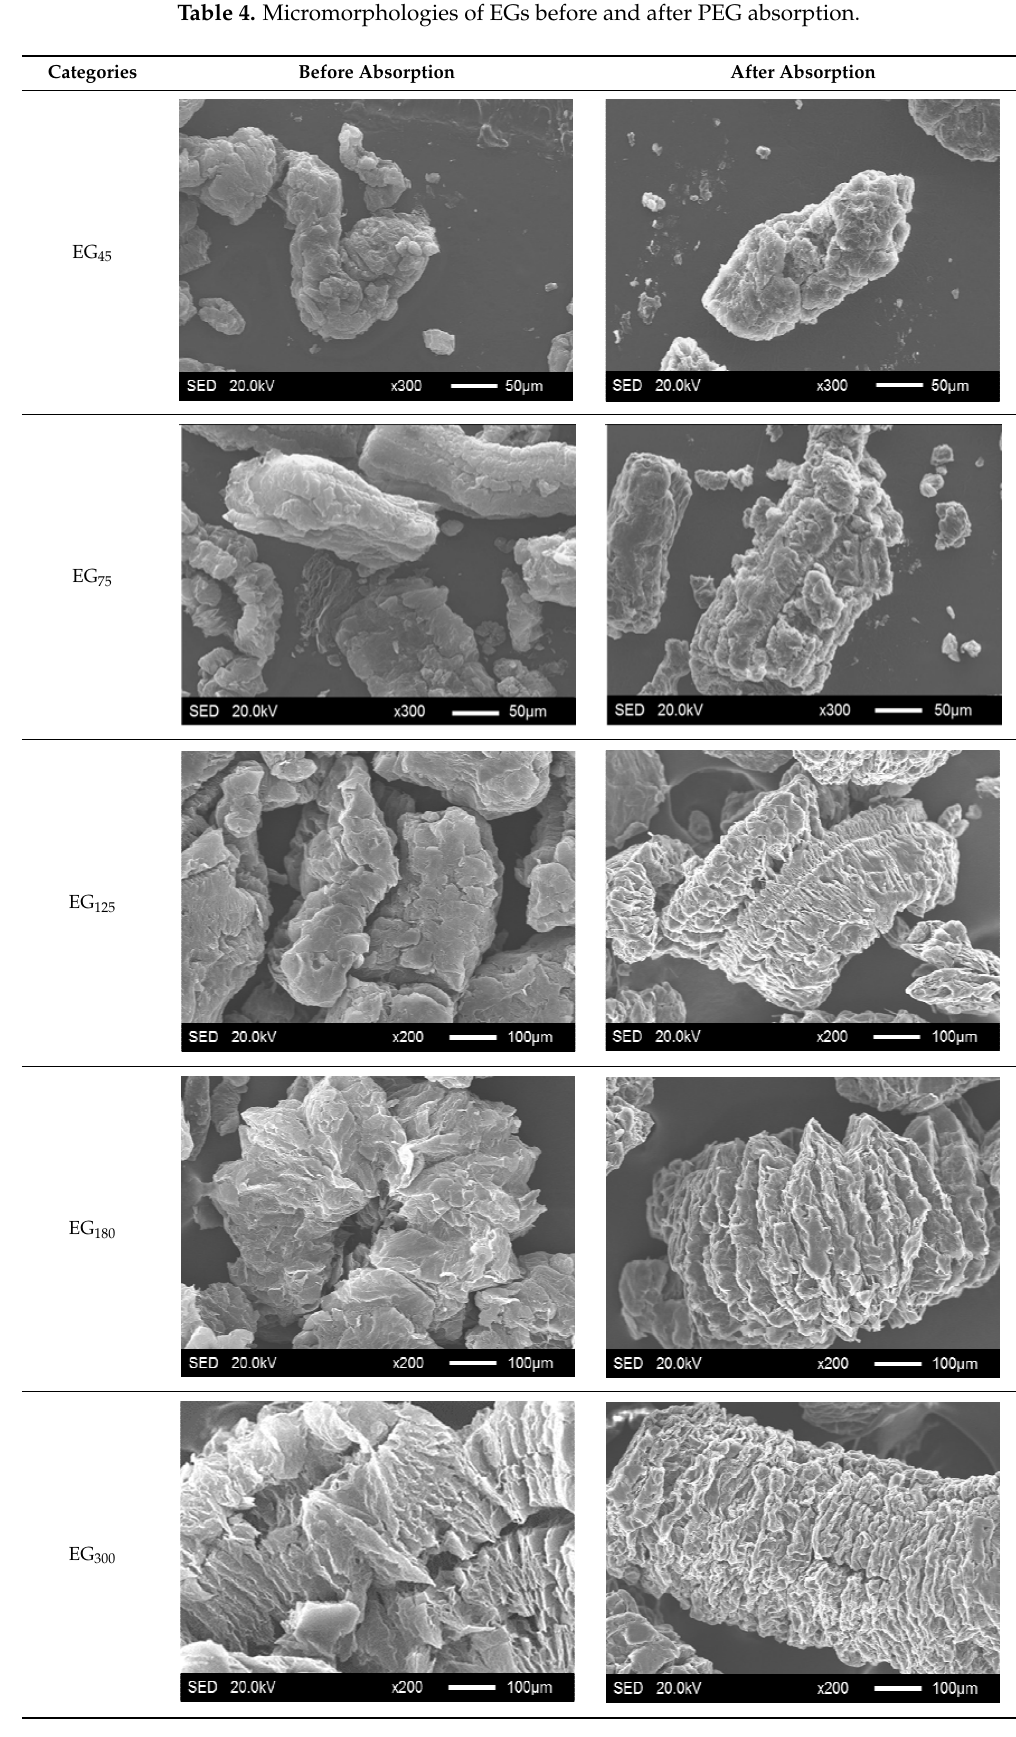
Table 4. Micromorphologies of EGs before and after PEG absorption.